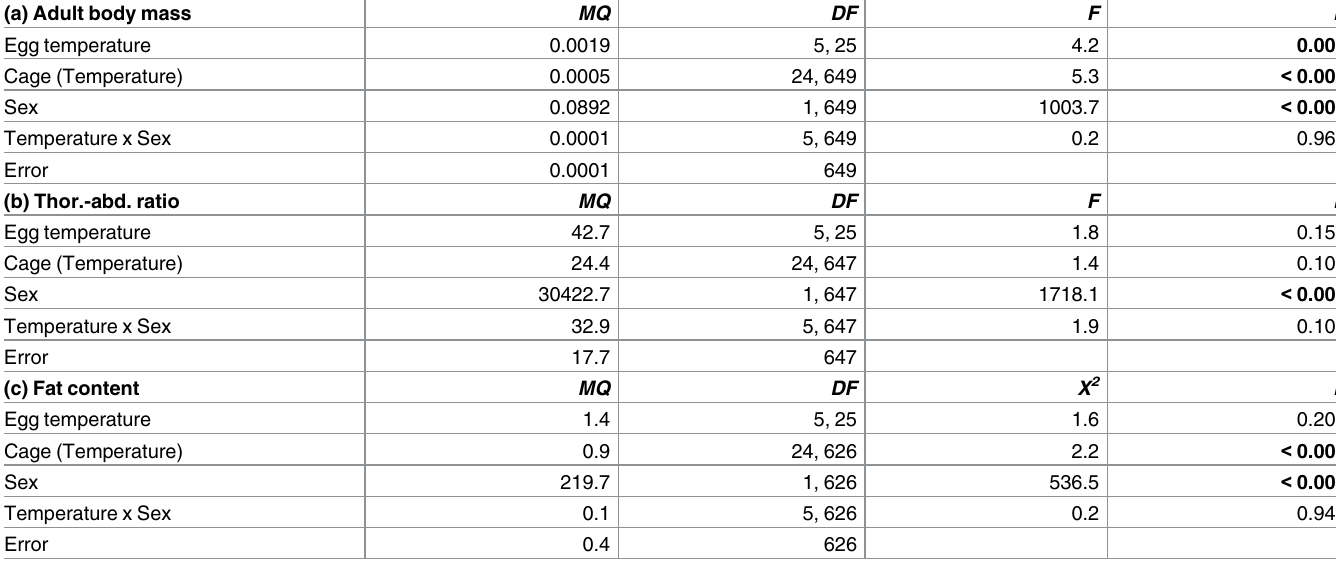
Table 3. Results of general linear mixed models (GLMMs) for the effects of egg temperature (fixed), cage (nested within temperature; random), and sex (fixed) on (a) adult body mass, (b) thorax-abdomen ratio, and (c) abdomen fat content in Bicyclus anynana . Significant P -valuesare given in